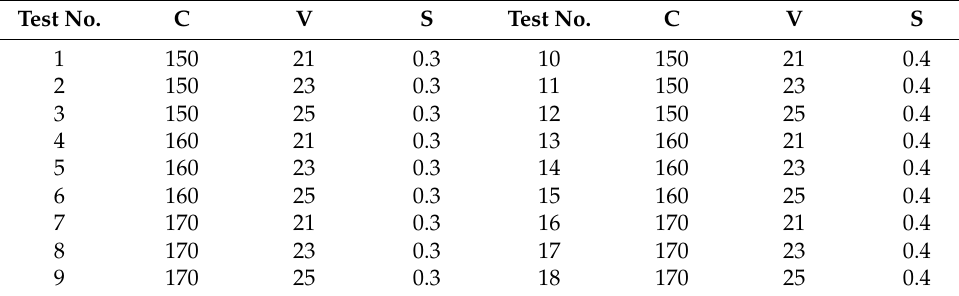
Table 4. Experimental conditions of flux-cored arc welding.